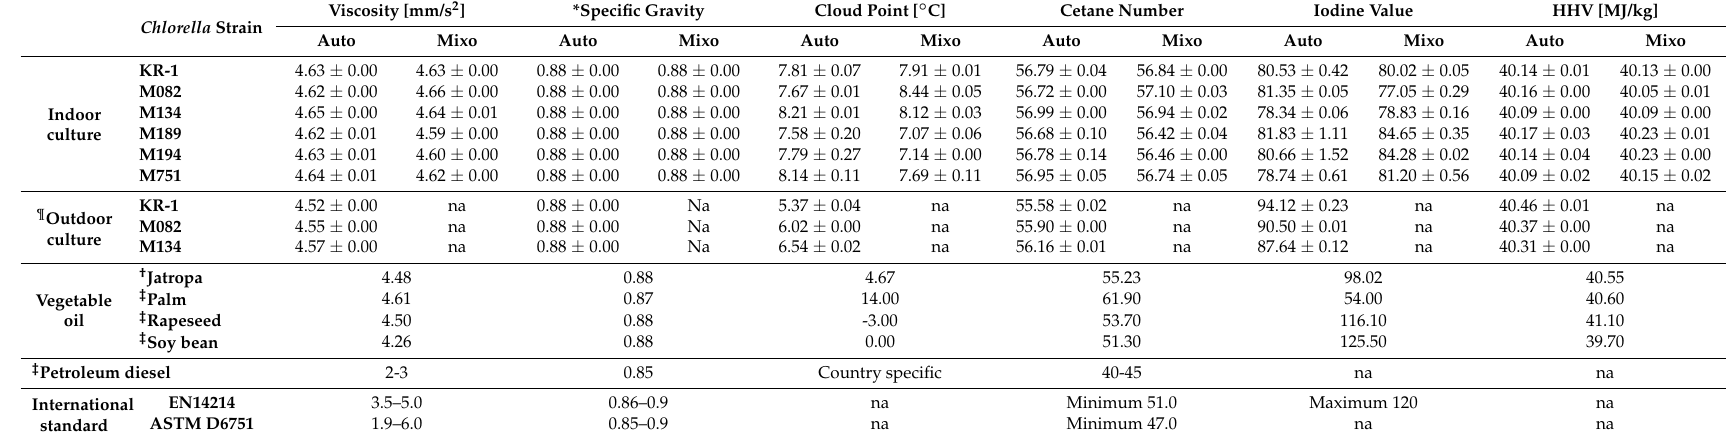
Table 2. Biodiesel properties of Chlorella strains under autotrophic and mixotrophic conditions indoors and outdoors compared with literature and